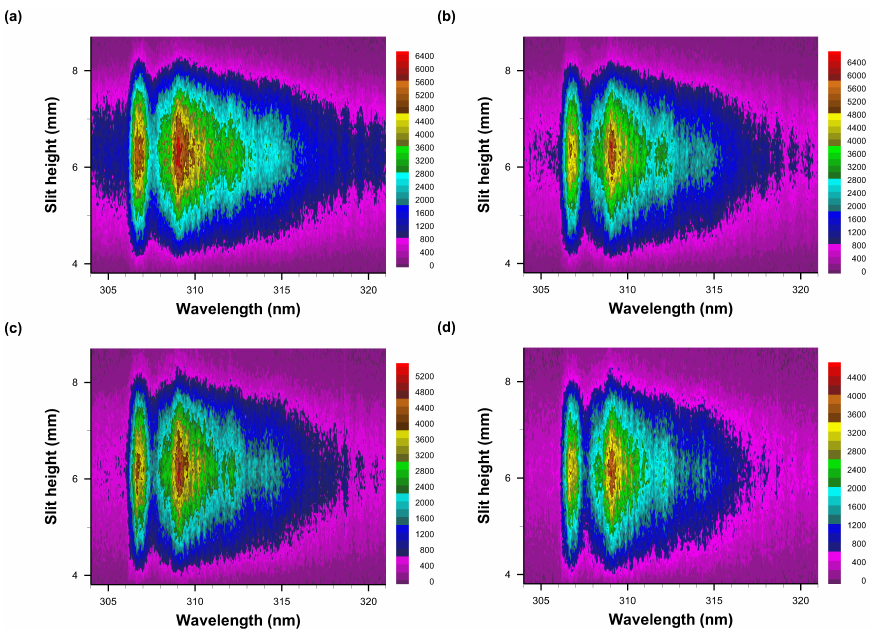
Figure 9. Recorded data of slit-height vs. wavelength. Gate width: 10 µ s, time delay ( a ) 50 µ s— primarily OH spectra, ( b ) 60 µ s, ( c ) 70 µ s, and ( d ) 80 µ s. Each pseudo-colored image is scaled from minimum to maximum with intensity values as indicated next to the color